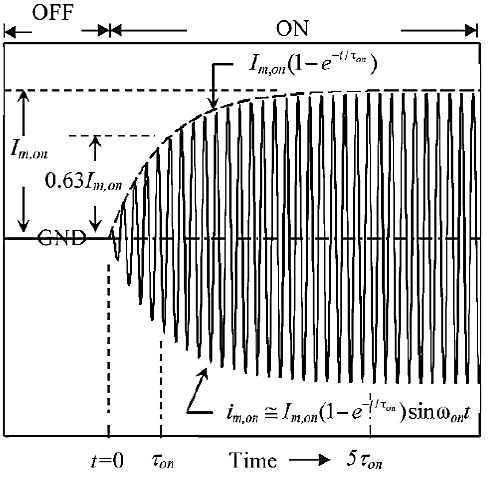
Figure 1. Transient response at the excitation AC constant voltage source.